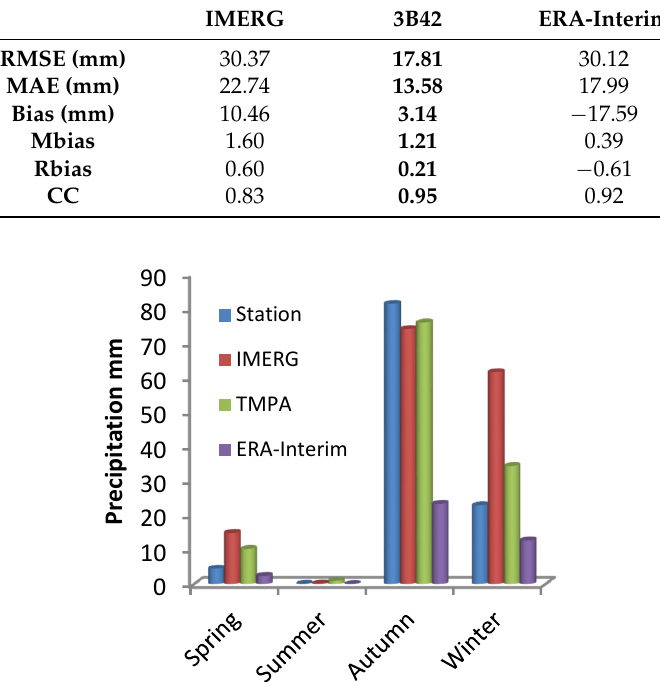
Figure 13. Bushehr seasonal precipitation.